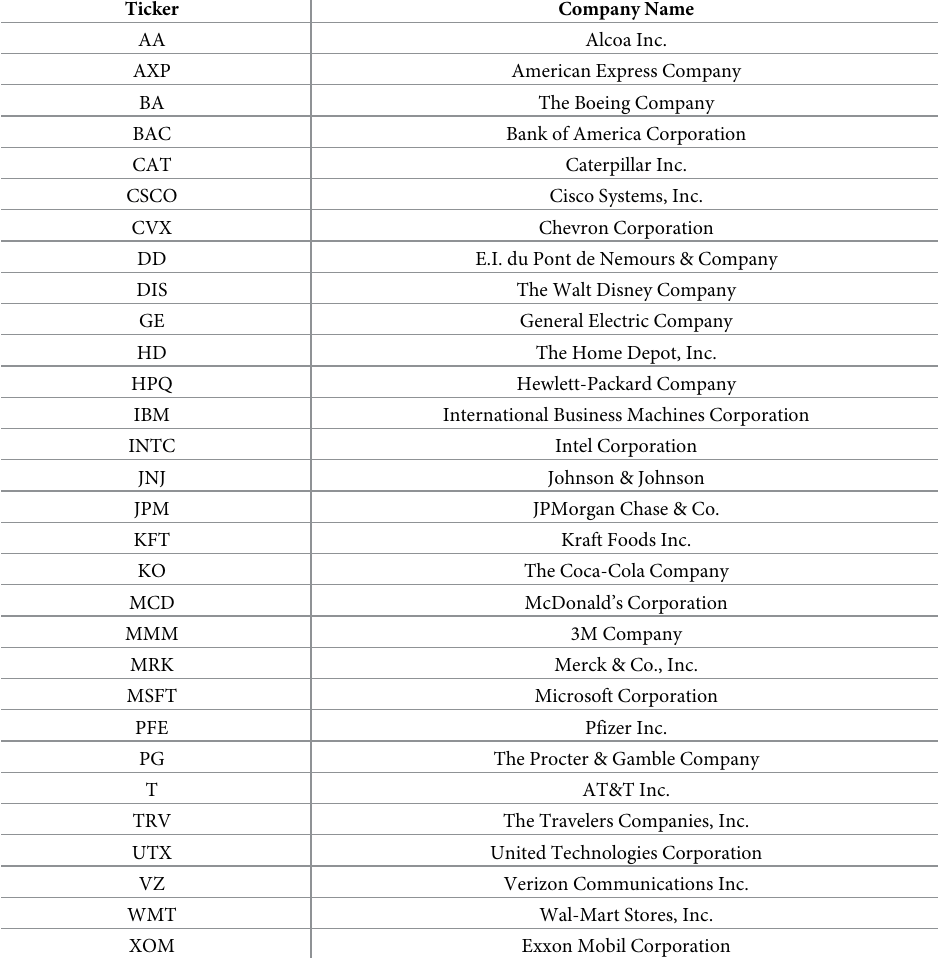
Table 1. Tickers and company full name of DJIA component stocks on June 8,